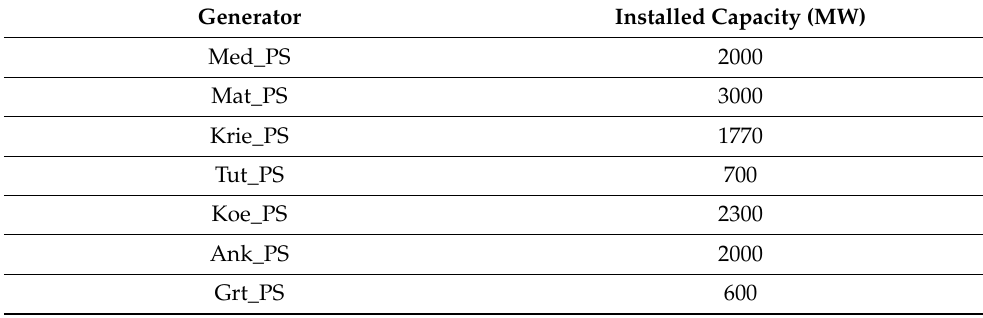
Table A1. Synchronous